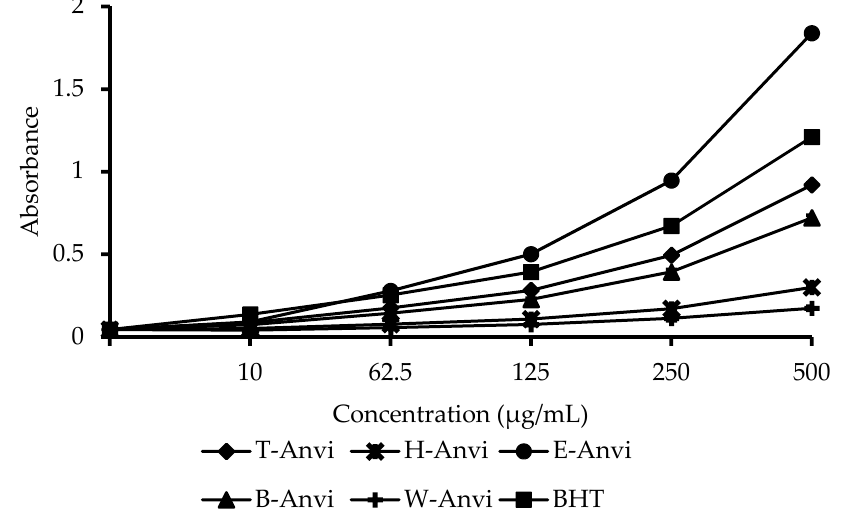
Figure 2. Potassium ferricyanide reducing power of A. virginicus extracts. T-Anvi, total crude extract; H-Anvi, hexane extract; E-Anvi, ethyl acetate extract; B-Anvi, butanol extract; W-Anvi, water extract; BHT, butylated hydroxytoluene.